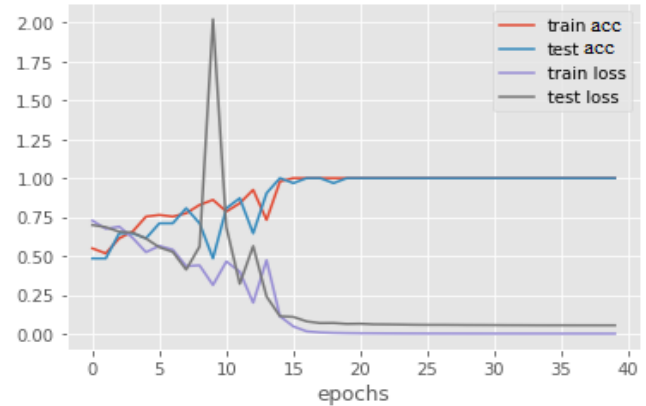
Figure A1. The Best Performance of the totally trained network for PD and HC classification.